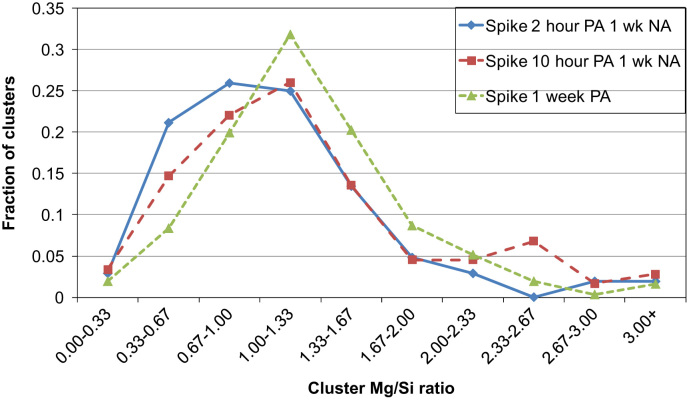
Fraction of clusters plotted against cluster Mg/Si ratio ranges after a spike followed by 2 or 10 h or 1 week PA as measured by LAR-3DAP.